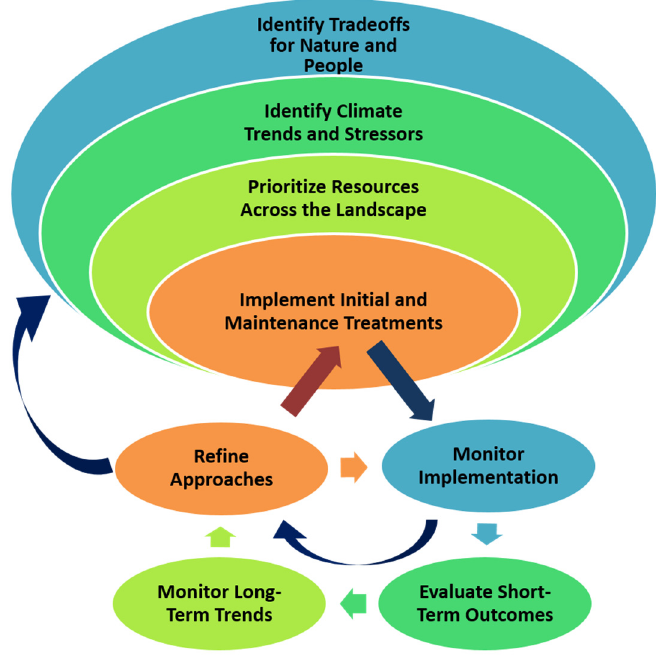
Figure 3. Adaptive management in a changing climate is nested and iterative, involving analysis, implementation, and monitoring to conduct initial work and to refine future and ongoing work. Our vulnerability assessment and workshop process help managers identify climate trends and stressors and prioritize resources across the landscape, which will ultimately feed into all levels of the adaptive management process. In the productive forests of southwestern Oregon the initial entry is the most costly, but ongoing maintenance treatments, preferably with managed fire, are needed to maintain a resilient landscape.